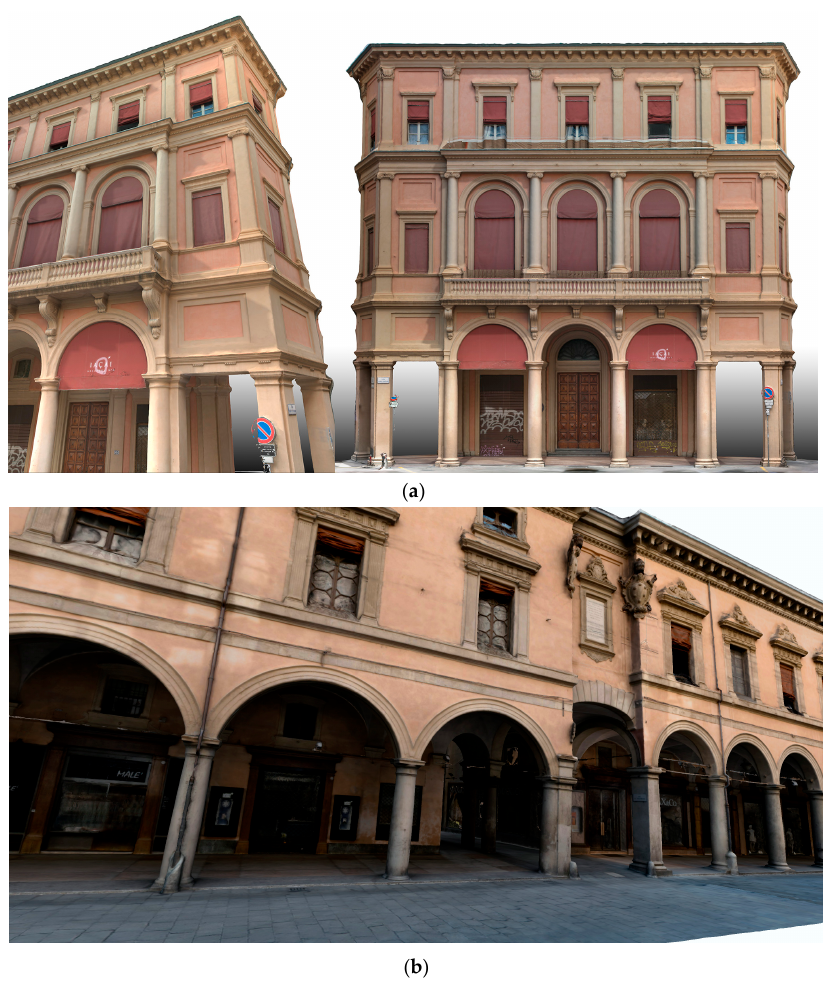
Figure 1. Results of the presented image-based 3D reconstruction of complex architectures (historical buildings with porticoes in Bologna) achieved with the presented methodology: ( a ) Palazzina in S.Tecla; ( b ) Palazzo dell’Archiginnasio; ( c ) Palazzo Assicurazioni